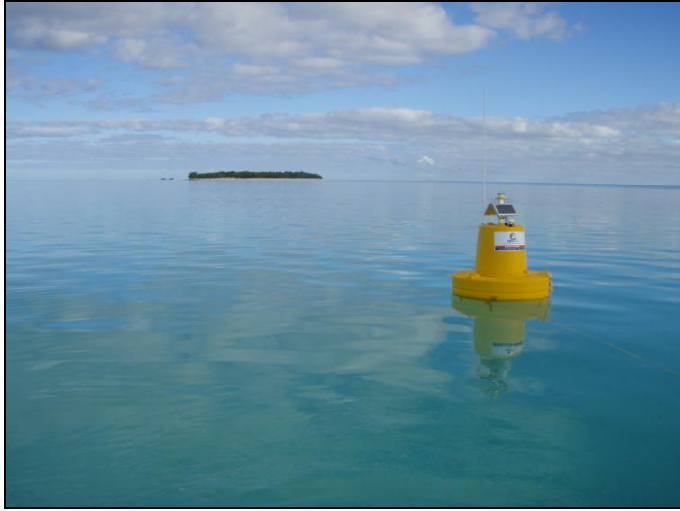
Figure 2. Photograph of a sensor-buoy at Heron Island, southern Great Barrier